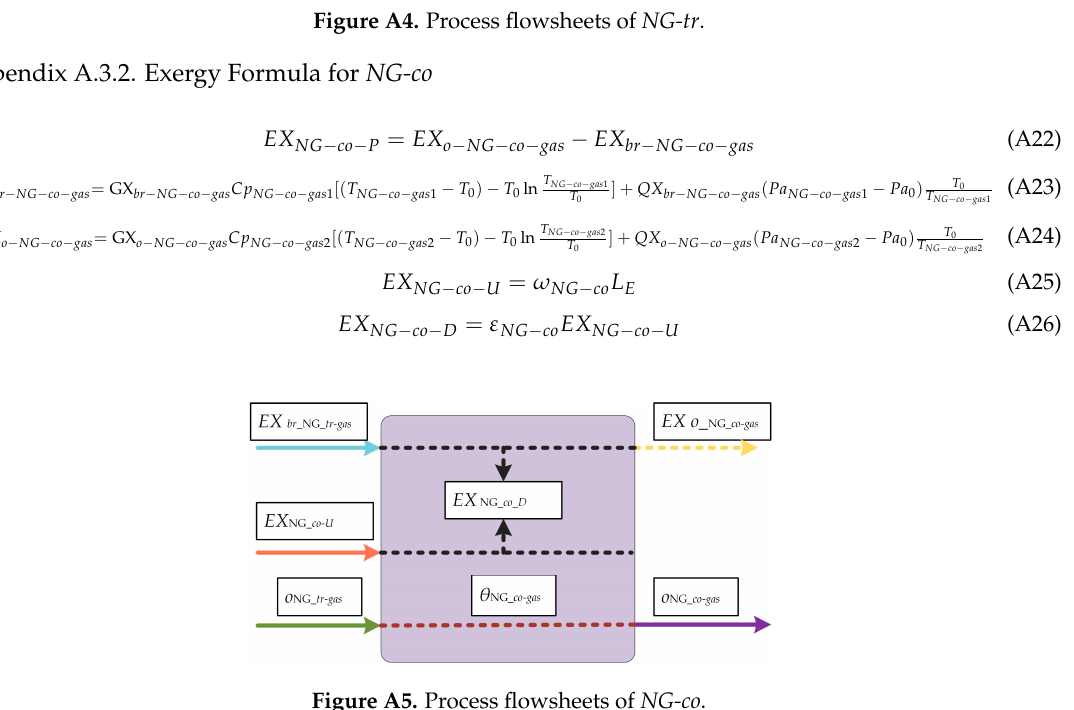
(A31) Figure A6. Process flowsheets of WT . A.5. Exergy Formula for Living-quarters System - swa LQ P